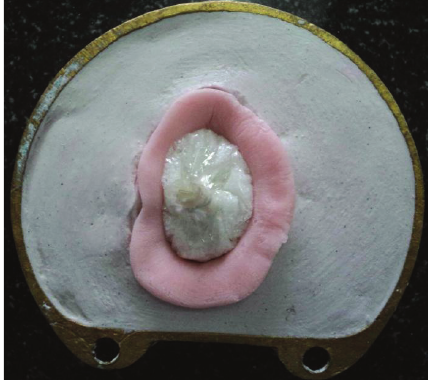
Figure 9: A pouch of packed salt.